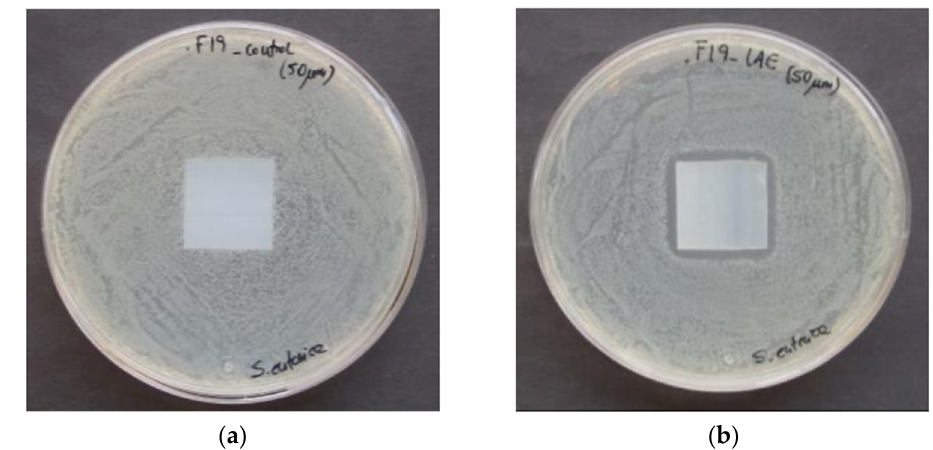
Figure 4. Petri dish with control film and 50 µm LAE film used against S. enterica after 24 h of incubation at 37 °C where ( a ) control sample; ( b ) 50 µm biofilm with LAE.